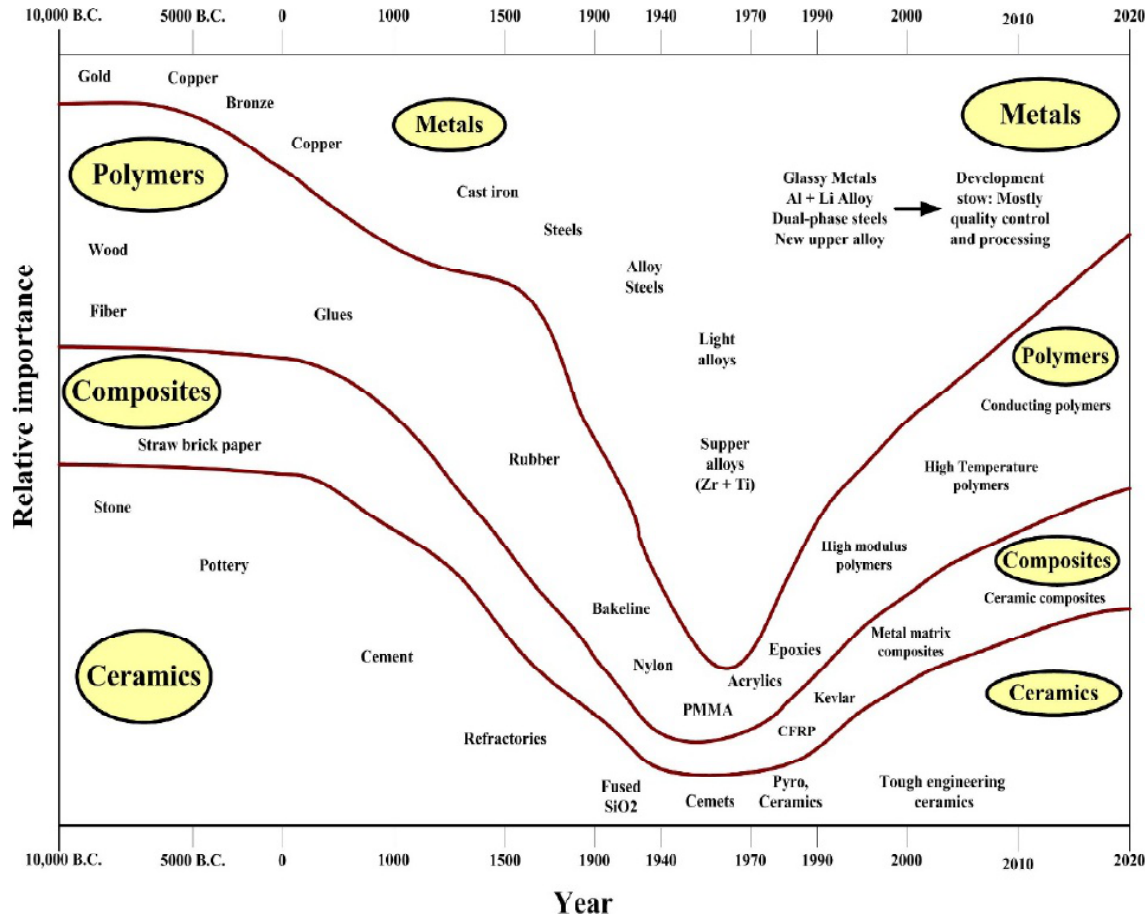
Fig. 8. Historical background of different materials (Redrawn and adapted figure from [107]). Commodity insulants, comprise polyethylene, copolymer, polystyrene, cellulose nitrate, polyvinyl chloride, styrene-acrylonitrile-copolymer, un-satu- rated-polyester and bismal-eimide. These materi- als have low cost, inferior characteristics and per- formance, large-consumption and extensive appli-